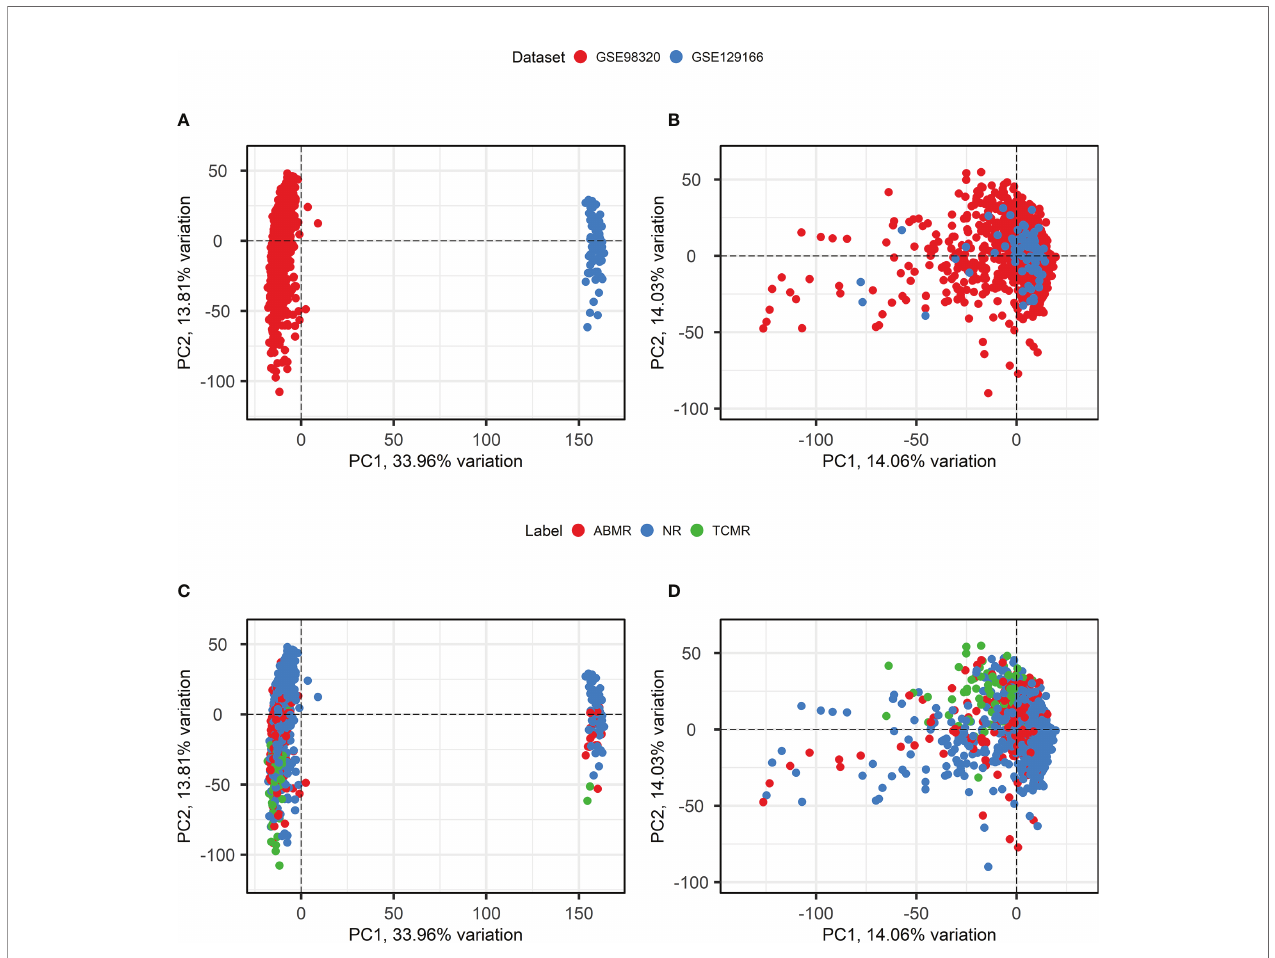
FIGURE 3 | Principal component analysis and Batch Correction. (A, B) . Principal component analysis biplots of samples labeled based on their origin dataset before (A) and after (B) batch effect removal using ComBat . (C, D) . Principal component analysis biplots of samples labeled based on their diagnosis before (C) and after (D) batch effect removal using ComBat . ABMR, Antibody-Mediated Rejection; NR, Non-Rejection; PC, Principal Component; TCMR, T-Cell-Mediated Rejection.